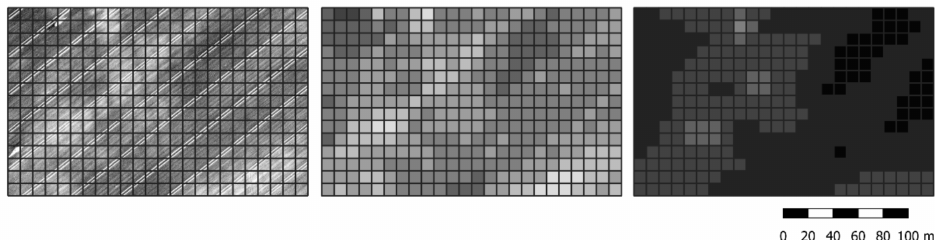
Figure 1. Section of a near-infrared (NIR) map and the generated grid-shapefile (white: 0.4–black: 0.85), Left: unmanned aerial vehicle (UAV)-provided resolution, Centre: UAV data averaged to 10 × 10 m 2 grid, Right: Sentinel data.